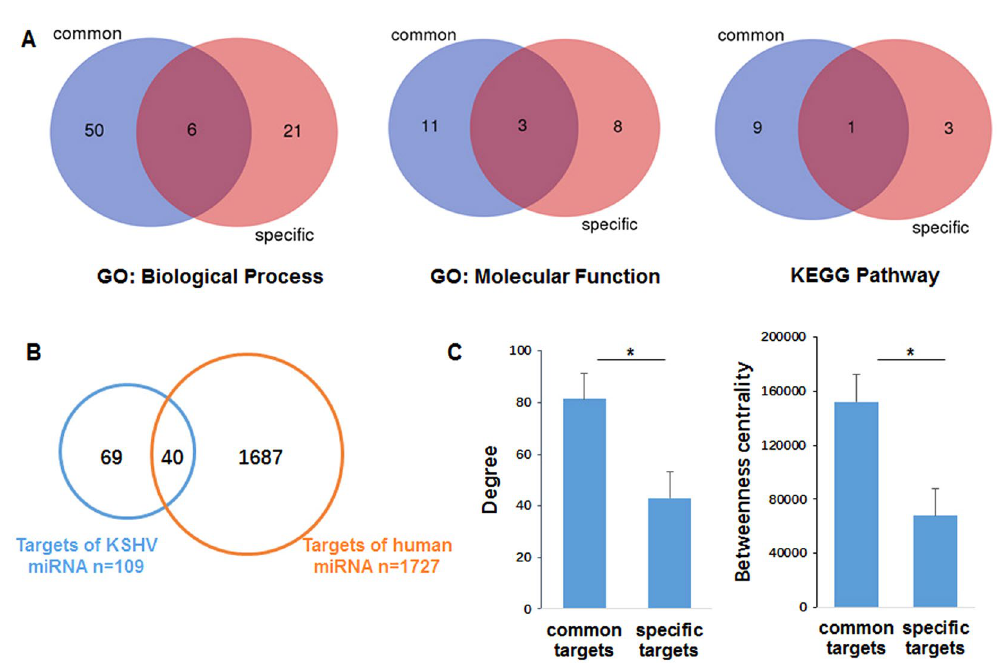
Figure 6. Difference analysis of common targets and specific targets. ( A ) The number and overlaps of GO: biological process, GO: molecular function and KEGG pathway terms (p-value < 0.05) for common targets and specific targets. ( B ) Overlaps of targets between KSHV miRNAs and human miRNAs. Blue represents KSHV miRNAs and orange represents human miRNAs. ( C ) Difference analysis of common targets and specific targets in terms of degree and betweenness centrality (t-test, * p <